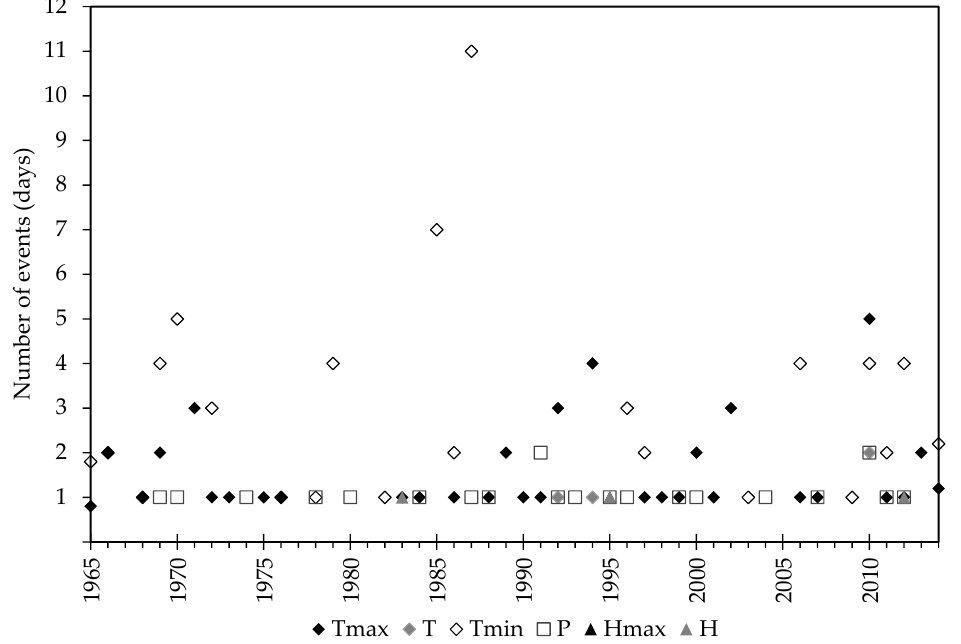
Figure 3. Occurrence of extreme hydrometeorological events with a 10% probability in the Polish Baltic coastal zone (collectively).